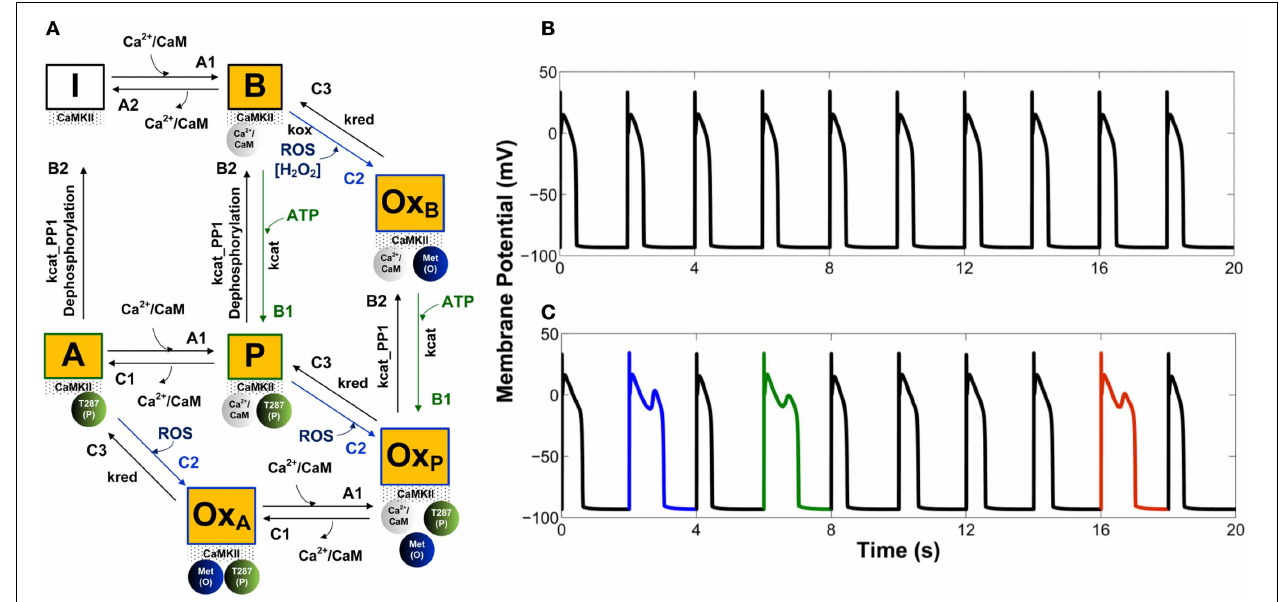
an active state that is both oxidized and phosphorylated (state Ox P ). (B) Simulated steady state APs under control conditions (0 µ M H 2 O 2 ). (C) Simulated APs, some of which exhibit EADs, under conditions of elevated oxidant stress (200 µ M H 2 O 2 ). Simulated APs are from a 2s PCL pacing protocol (ensemble of 12500 calcium release units). For each condition, results for 10 consecutive APs following an initial 10s of pacing are